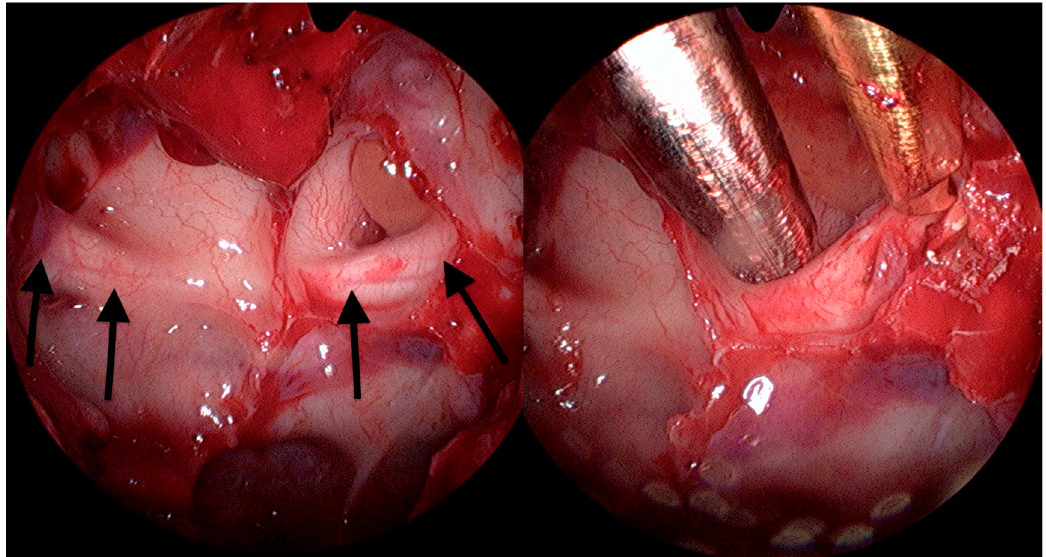
Figure 2. Sphenoidal sinus view. The image left shows prominence of both optic nerves (arrows). Right : decompression of the left ON is shown.